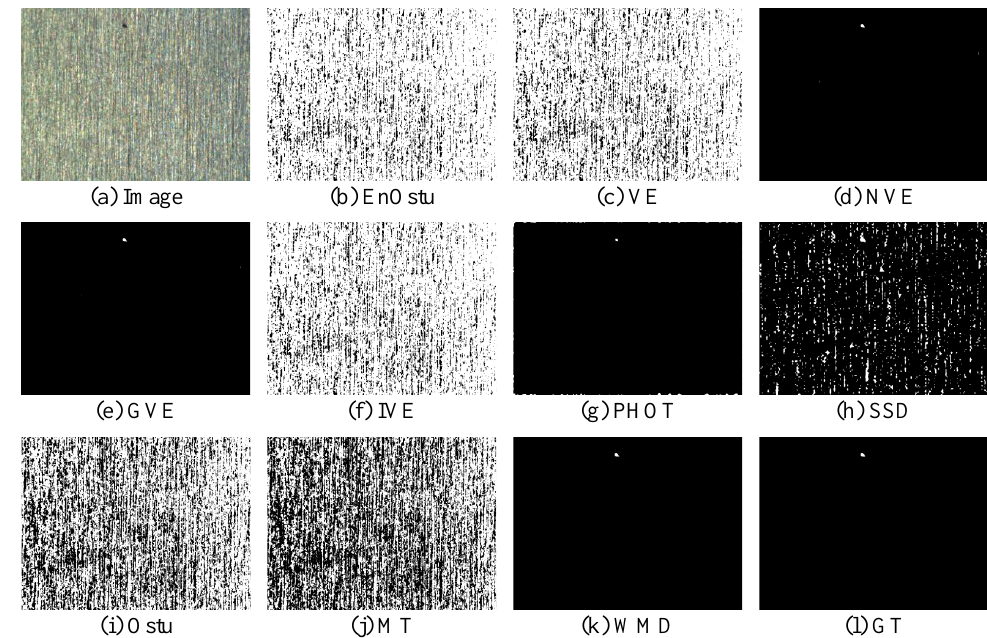
Figure 7. Visual comparisons of detection results of the ten methods on the image with a single defect. Our detection result (WMD) is quite close to ground truth.